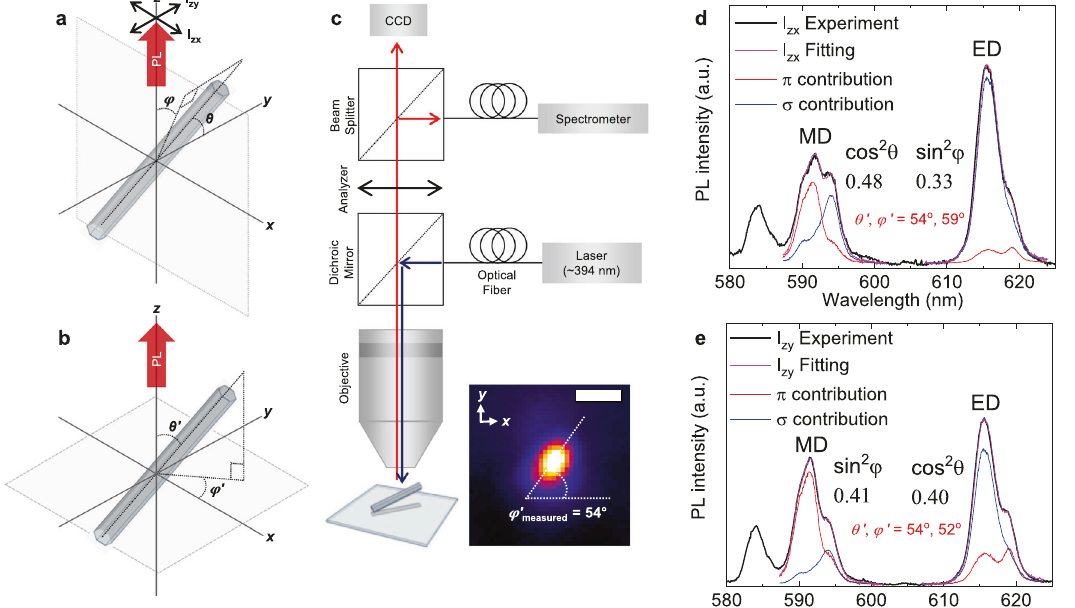
Fig. 3 Orientation analysis of a single NaYF 4 :Eu nanorod by spectral fi tting. a – b Schematic illustration of a hexagonal crystalline NaYF 4 :Eu nanorod with an arbitrary 3D orientation denoted by the spherical angles ( θ , φ ) or ( θ ′ , φ ′ ) when the polar axis is ( a ) y -axis or ( b ) z -axis respectively. The observation plane is fi xed as xy-plane. c A scheme of the optical microscopy setup used to conduct the orientation analysis. The inset is a photograph of the photoluminescence (PL) of a single nanorod captured by the CCD camera (scale bar: 1 µ m). The in-plane angle ( φ ′ ) of the nanorod was found as the long axis of the ellipsoidal shape of this image. d , e Spectral fi tting analysis using a polarized PL spectrum I zx or I zy obtained with the analyzer ( d ) parallel to the x -axis or ( e ) parallel to the y -axis. Each analysis considers both ED and MD transitions in order to determine θ and φ from a single spectrum using Eqs. 4 – 9. The calculated values of the trigonometric functions of ( θ , φ ) and the absolute values of ( θ ′ , φ ′ ) are presented in the fi gure. The results of the same analysis for a large number of particles are shown in the supplementary information (Supplementary Fig. 8, Supplementary Data